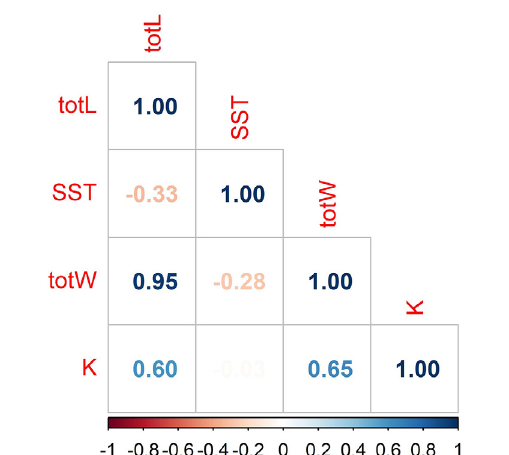
Fig. S2. – Correlation plot among variables. totL, total length (cm); totW, total weight (g); SST, sea surface temperature (°C); and K, Fulton’s condition